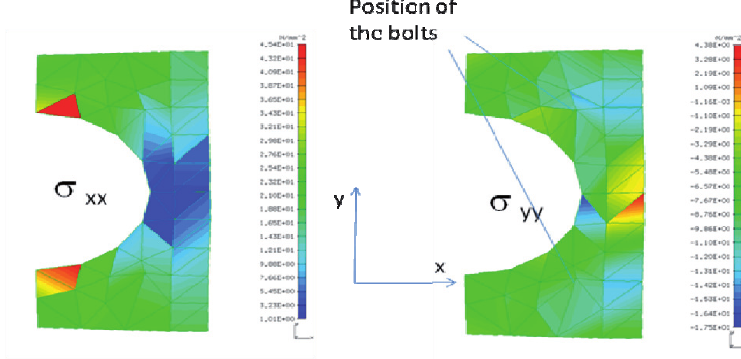
Fig. 13. Results for the centrifugal